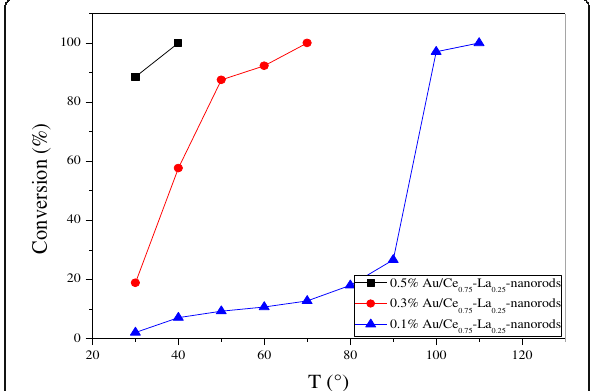
Fig. 9 Catalytic activities of 1% Au/ La-Ce nanorods with different La content calcined at 300 °C for 2 h